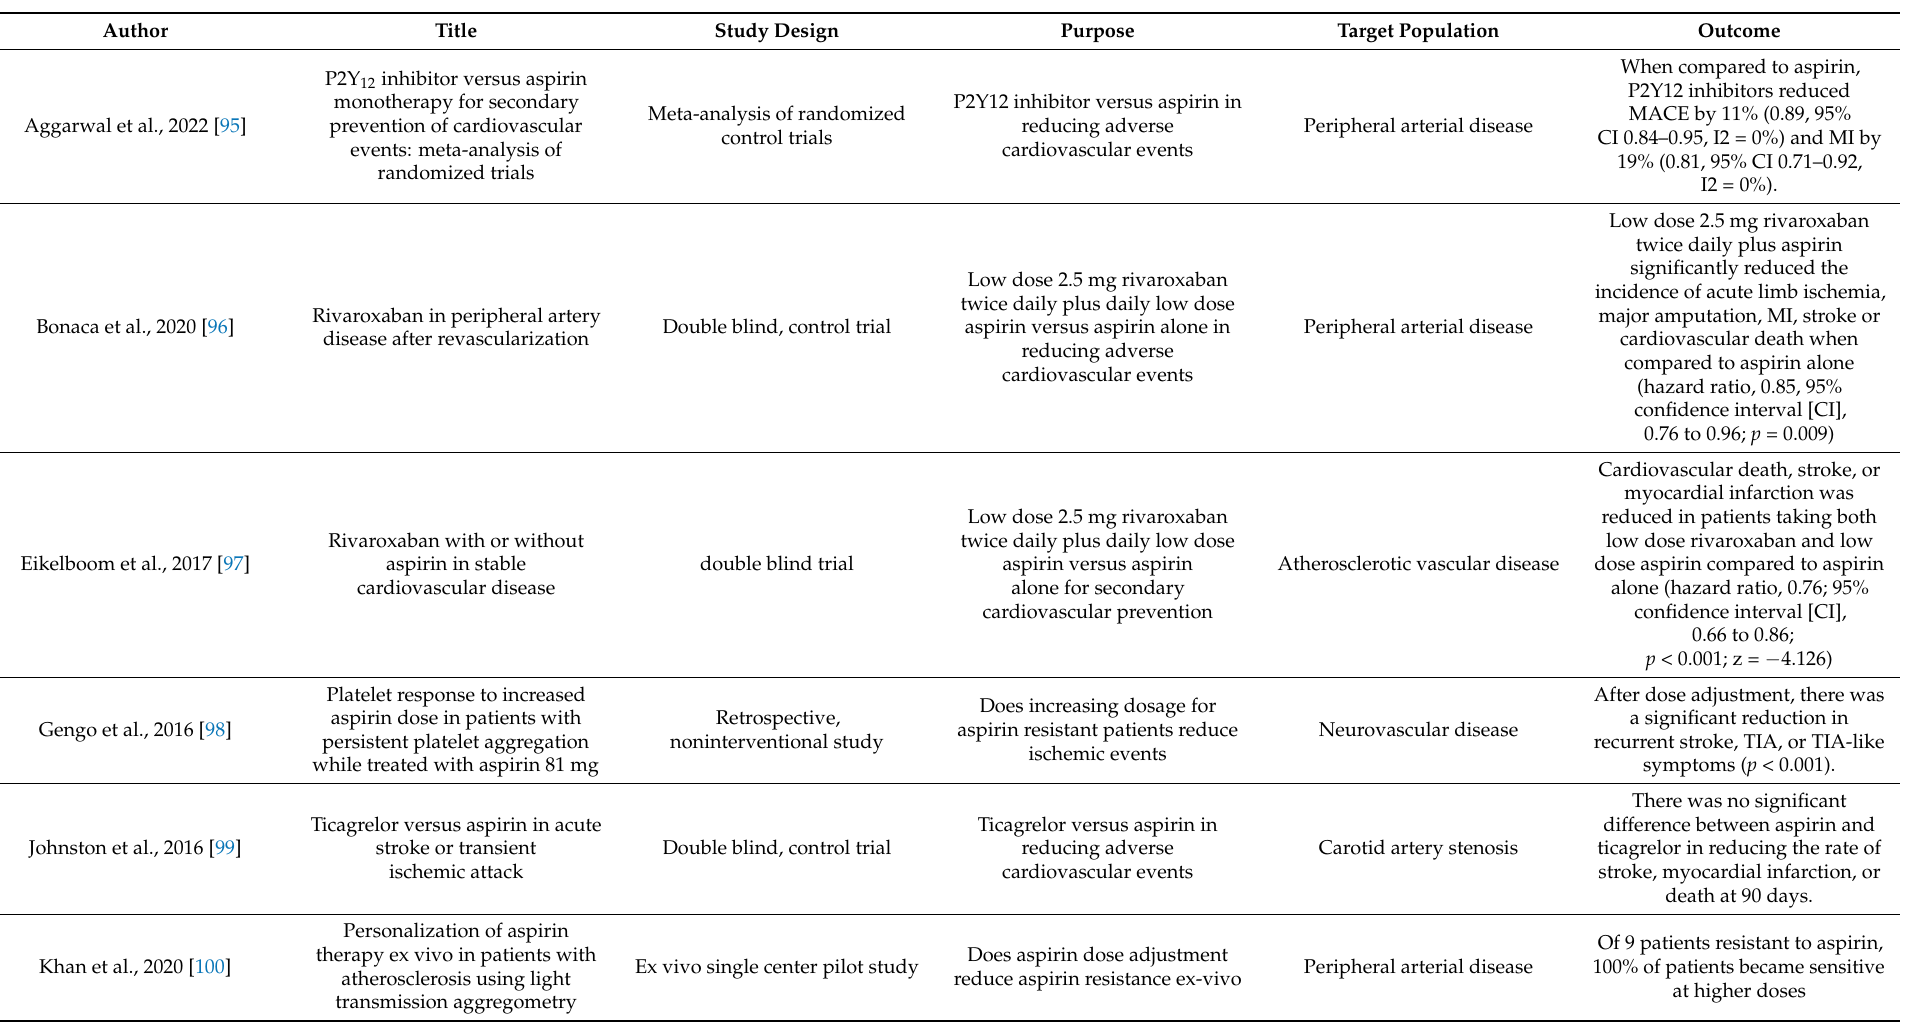
Table 1. Studies investigating alternative therapies in patients with aspirin resistance. MI: myocardial infarction; CI: confidence interval; TIA: transient ischemic attack; MACE: major adverse cardiovascular